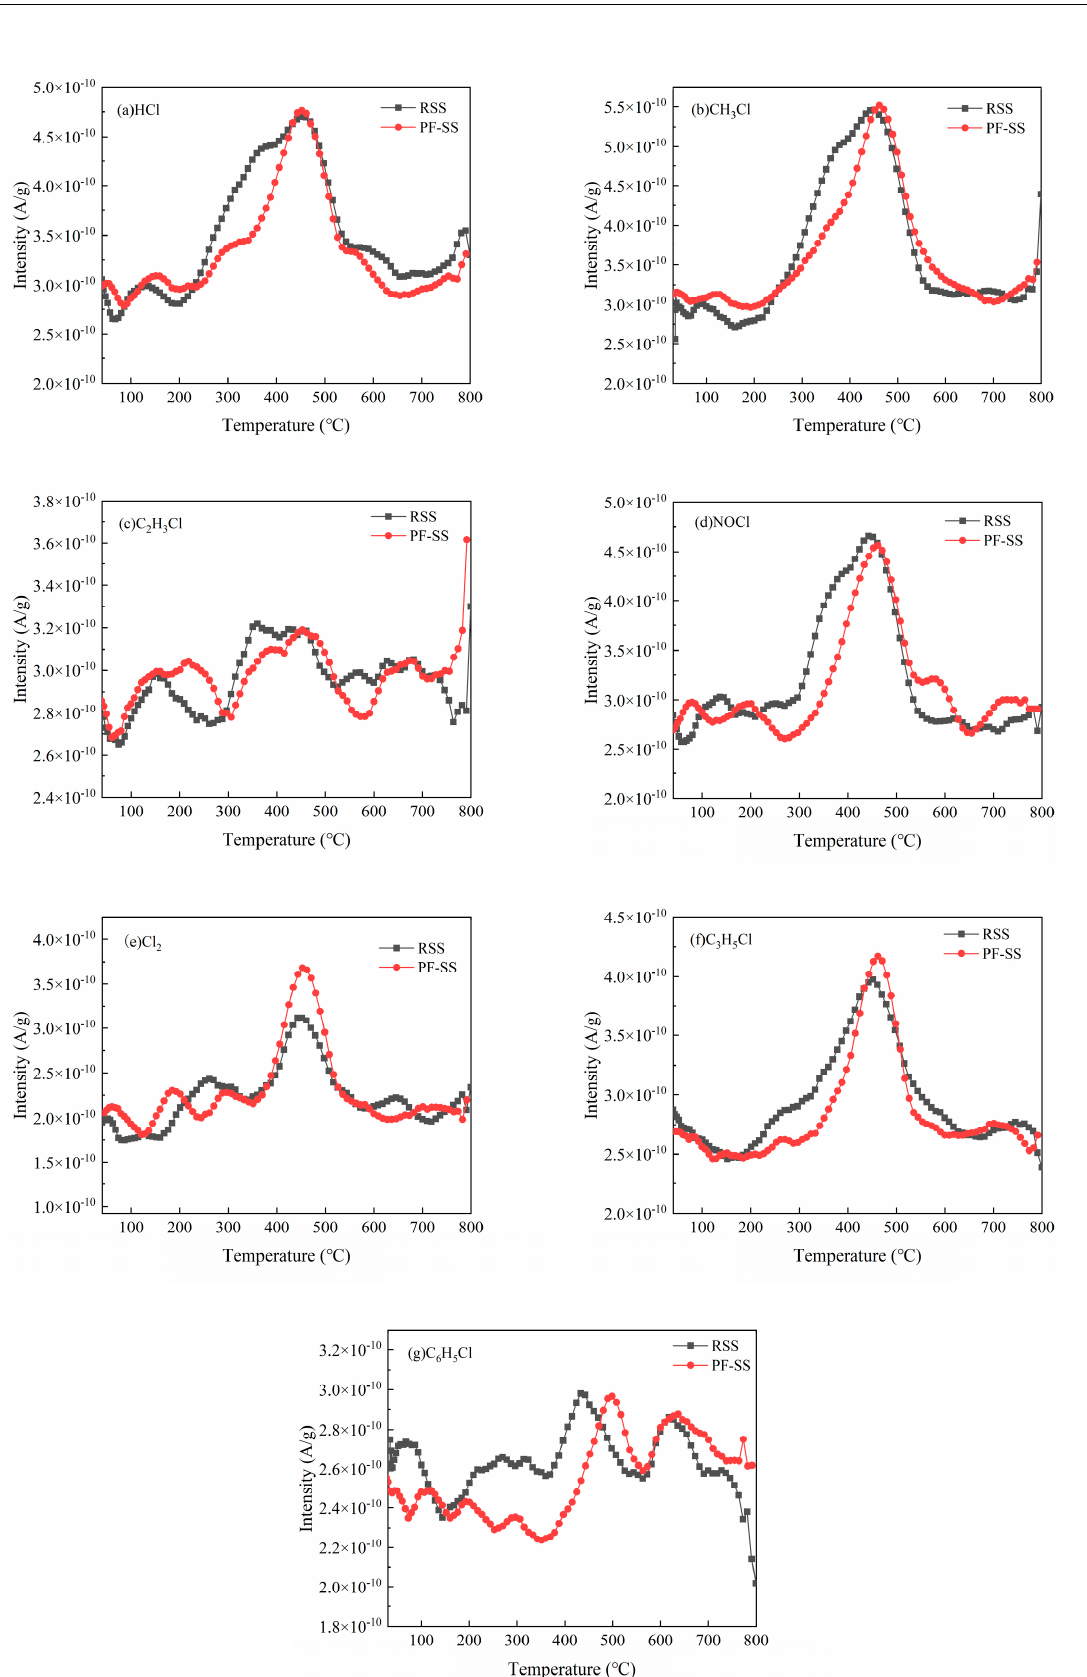
Figure 5. Main Cl-containing pollutant gas products released during the pyrolysis of different